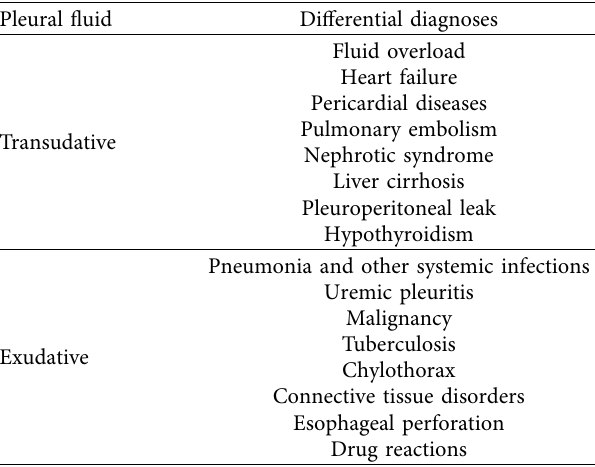
Table 2: Etiology of pleural